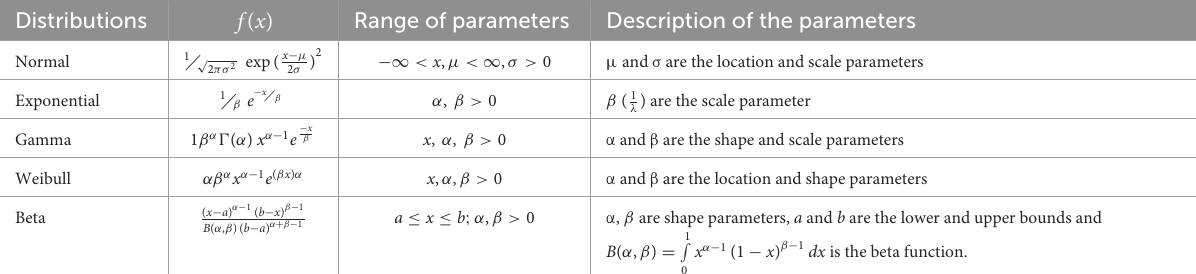
TABLE 1 The first five univariate continuous probability distributions